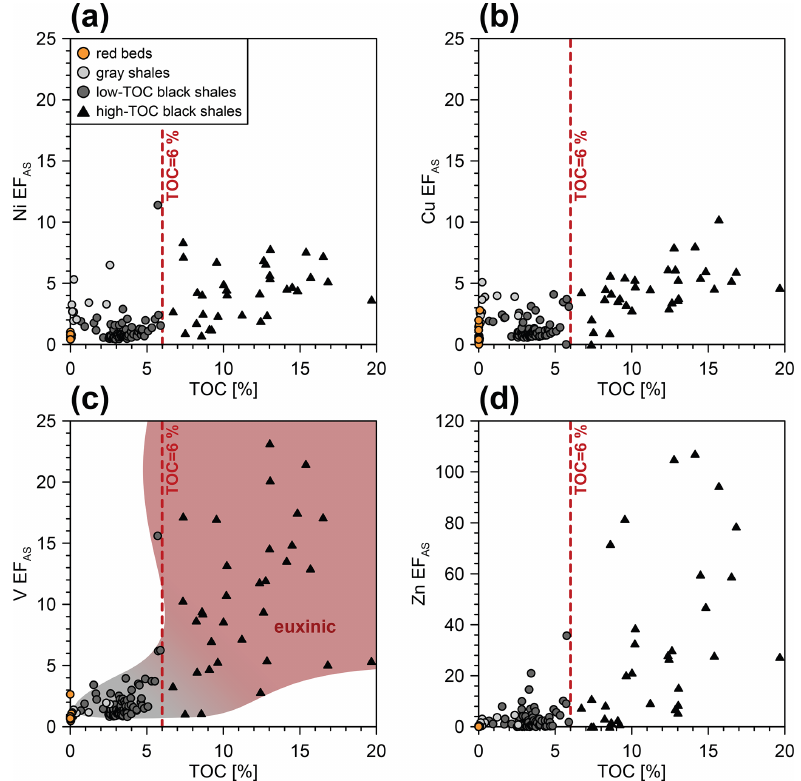
Figure 7. Cross-plots of total organic carbon content and average shale-normalized enrichment factors (EF AS ) of (a) Ni, (b) Cu, (c) V, and (d) Zn. Black triangles indicate high-TOC black shales ( > 6% TOC). TOC data are taken from Dummann et al.